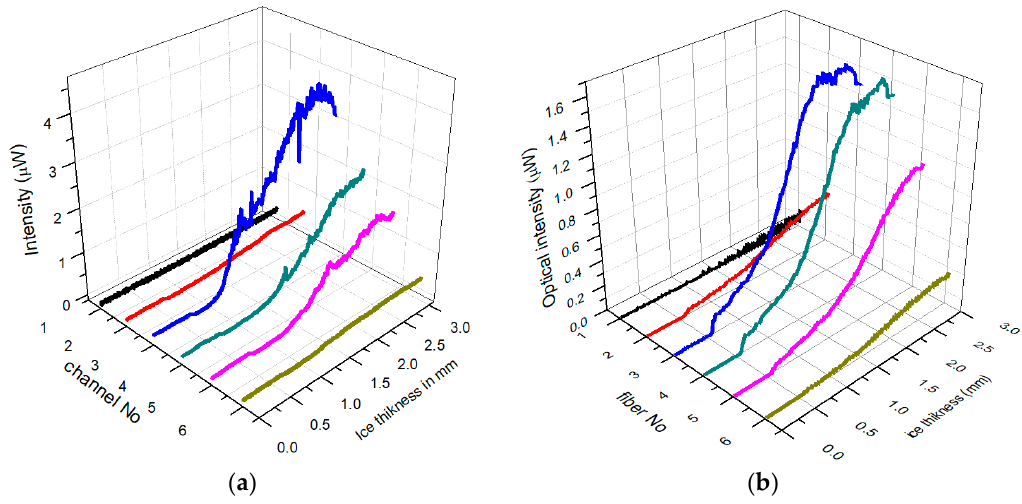
Figure 17. Optical measurements of ice thickness with POF taper fiber-array sensor (LWC 0.5 mL/m 3 and 20 μ m water droplets) ( a ) glazed ice ( − 5°C) ( b ) rime ice − 25°C.